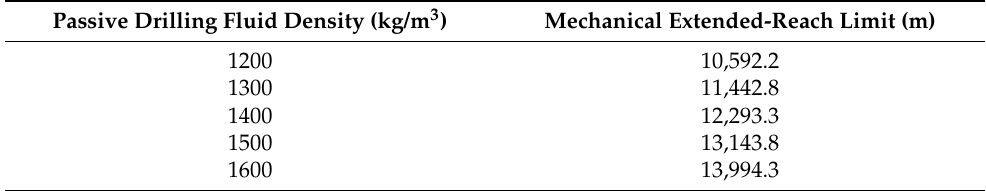
Table 8. Mechanical extended-reach limits with different passive drilling fluid